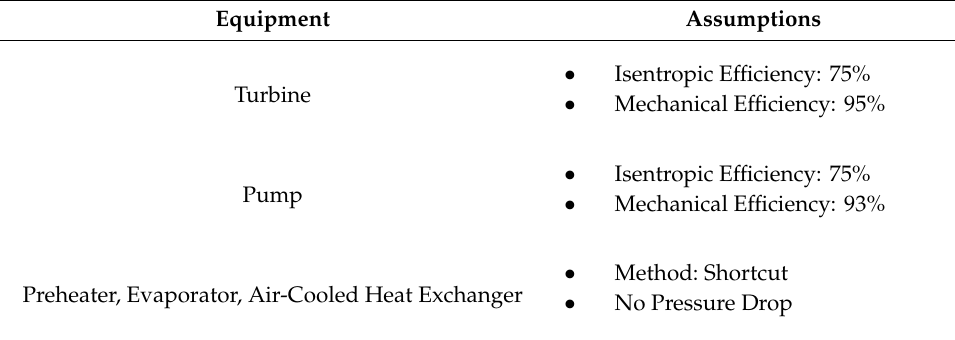
Table 3. Assumptions for the